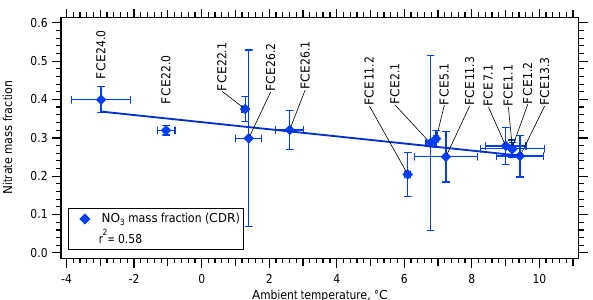
Figure 6. Mass fraction of nitrate (mean value for each FCE) in cloud droplet residues (CDRs) as a function of temperature. Error bars represent the standard deviation of concentration and temper- ature during the cloud events. The line represents a linear fit to the data; the correlation coefficient is given in the